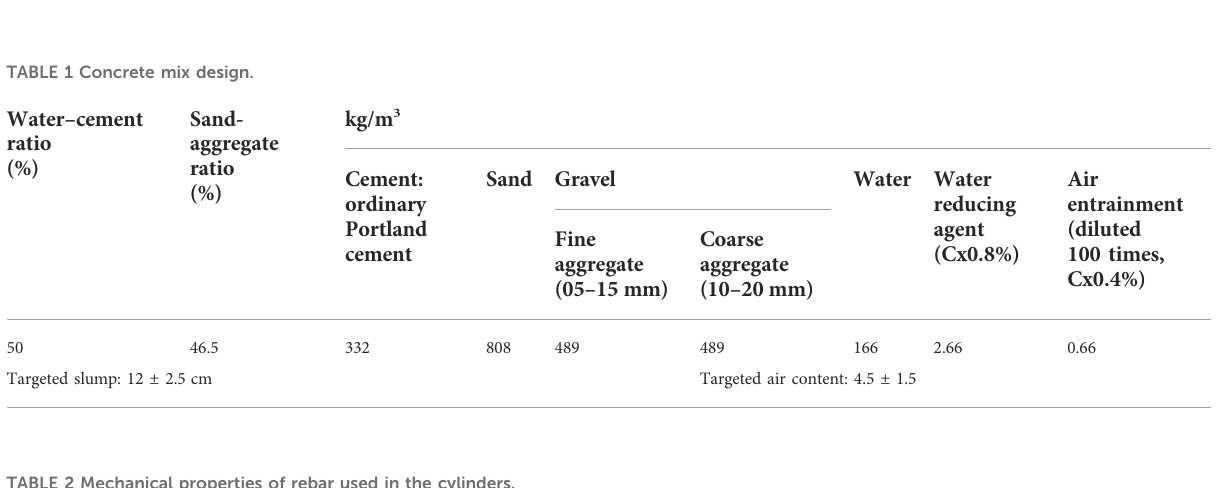
TABLE 2 Mechanical properties of rebar used in the